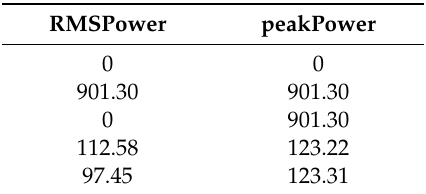
Table 4. Cluster means found through the fuzzy C-means (FCM) clustering in this experimentation and used as center parameters of the Gaussian basis functions of the radial basis function (RBF) artificial neural network (ANN) model to be heuristically initialized.